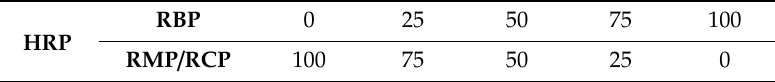
Table 2. Hybrid recycled powder (HRP) mixing proportion design (%) .